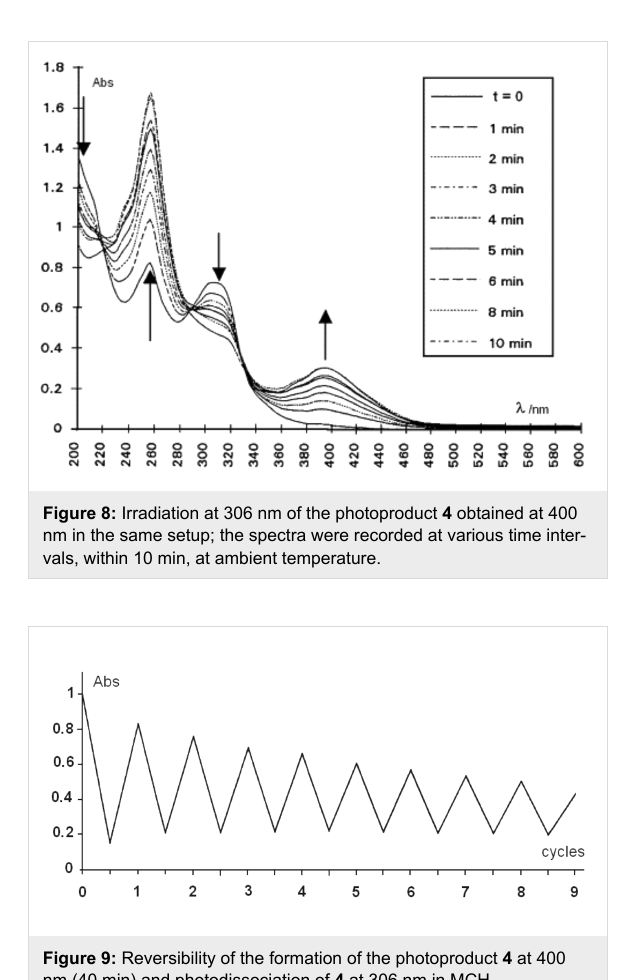
Figure 9: Reversibility of the formation of the photoproduct 4 at 400 nm (40 min) and photodissociation of 4 at 306 nm in